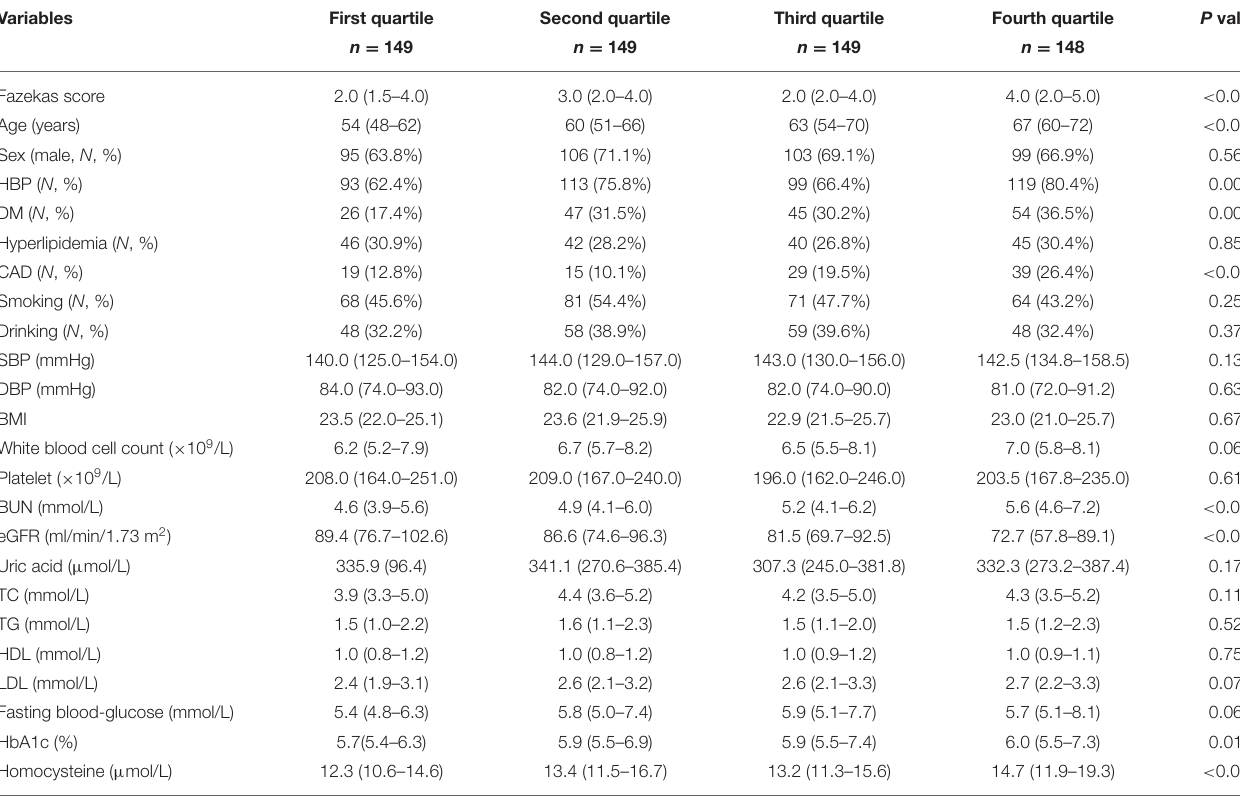
TABLE 1 | Baseline characteristics of patients with ischemic stroke according to PAGln quartiles.